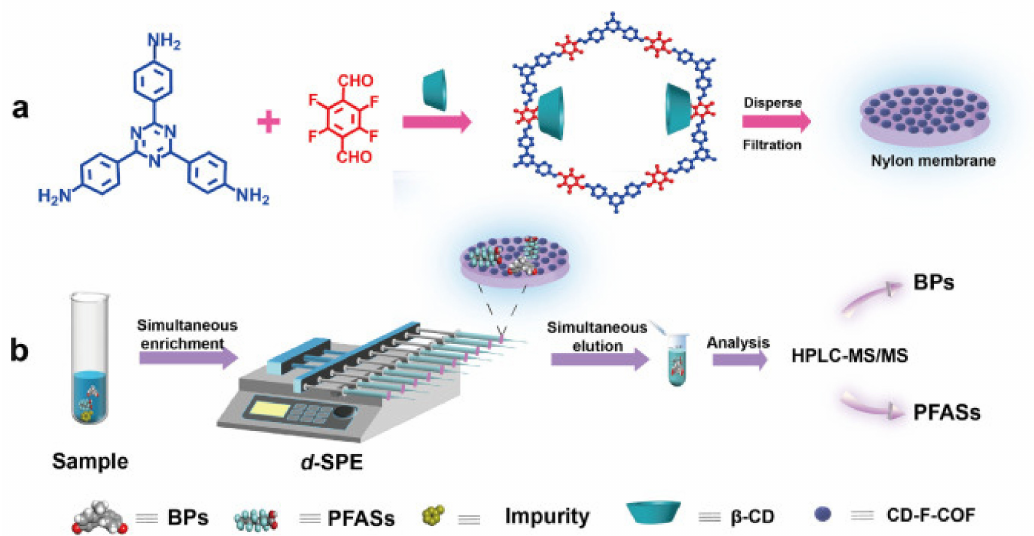
Figure 5. Summary of simultaneous enrichment and determination procedures through d -SPE based on CD-F-COF membrane (reprinted from [114] with permission from